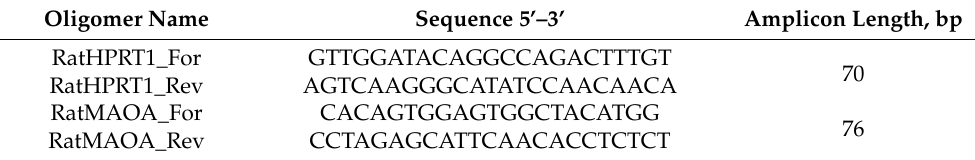
Table 2. Primers used in RT qPCR